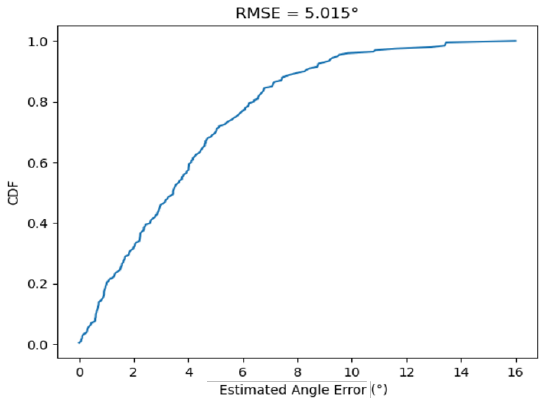
Figure 11. CDF of the direction error in the experiment.